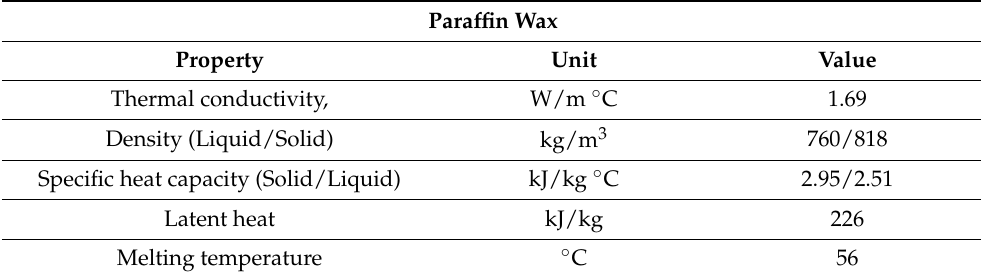
Figure 2. Experimental View of Latent Heat Storage Based Single-Slope Solar Still Assisted with Solar Air Heater. Table 1. Thermo-physical properties of paraffin wax and black